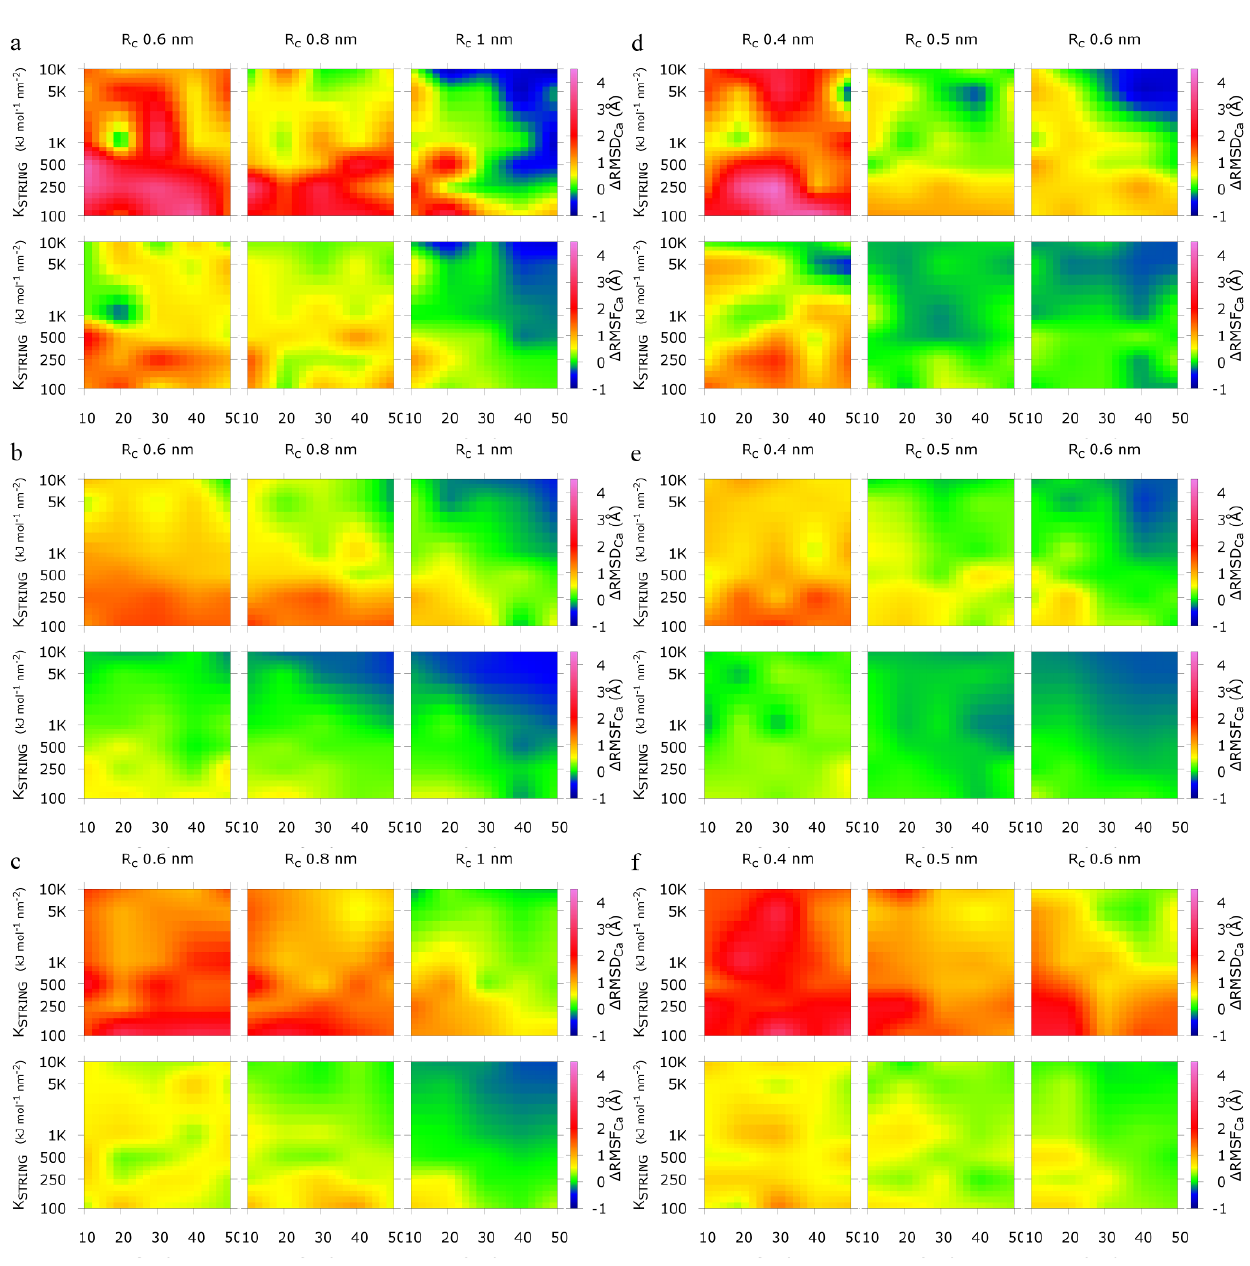
Figure 1. Comparison between atomistic and Surface Accessibility Hydrogen-Bonds elastic NETwork backbone beads (SAHBNET BB)[left column: ( a – c )] and side-chains beads (SC) [right column: ( d – f )] CG simulations of ( a , d ) the villin headpiece subdomain, ( b , e ) the α -spectrin SH3 domain and ( c , f ) the B1 domain of protein G. Value of Delta-Root-Mean-Square Deviation of the C α ( Δ RMSD ), Delta-Root-Mean-Square C α Fluctuation of the C α ( Δ RMSF ) are reported as a function of the restraint energy C α (K ; vertical axis) and the SA cut-off (horizontal axis) for each R values. Green zones SPRING c correspond to parameters for the SAHBNET where the CG structure behavior is the closest to the atomistic one. Blue zones, corresponding to negative values, indicate parameters for which the movements of the CG structure are too much hindered by the